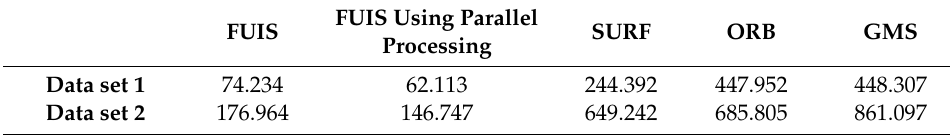
Table 2. Time cost by the methods to stitch the image sequence (second).